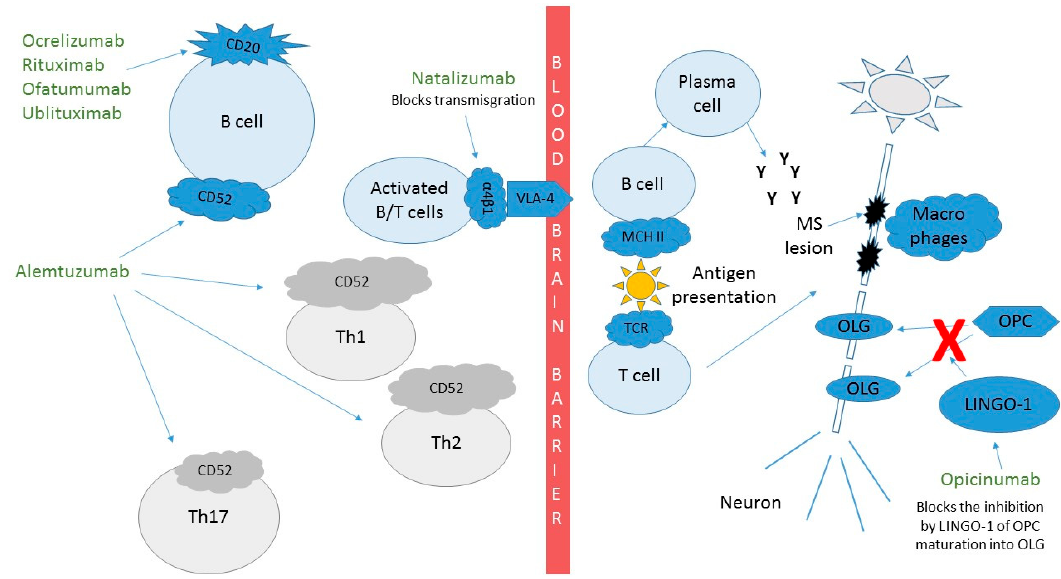
Figure 2. Mechanism of action of monoclonal antibodies in the treatment of multiple sclerosis. Ocrelizumab, rituximab, ofatumumab and ublituximab target CD20 expressing cells. Natalizumab targets transmigration of lymphocytes through the blood brain barrier. Alemtuzumab targets CD52 expressing cells. Opicinumab helps OPC differentiate into myelin producing OLGs. Cluster of differentiation (CD), T helper cells (Th), Leucine rich repeat and Immunoglobin-like domain-containing protein 1 (LINGO-1), oligodendrocyte (OLG), oligodendrocyte precursor cell (OPC).